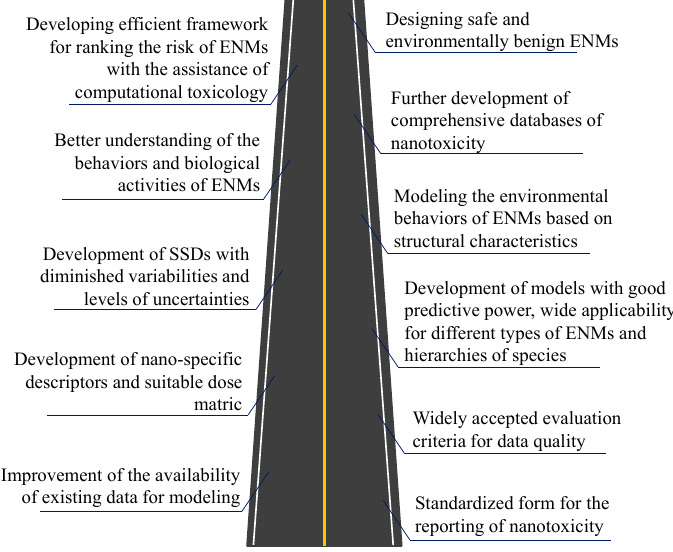
Figure 5. A roadmap indicating the future milestones of using computational toxicology in assisting the hazard assessment of ENMs.